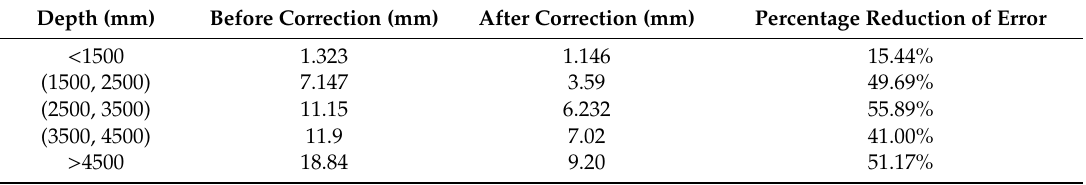
Table 4. Error of 3D reconstruction before and after depth